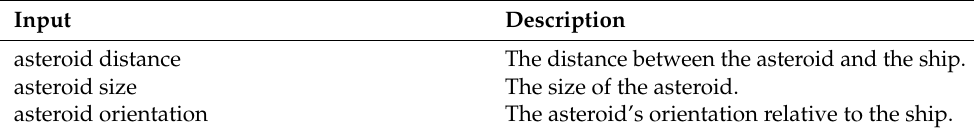
Table 4. XAI core